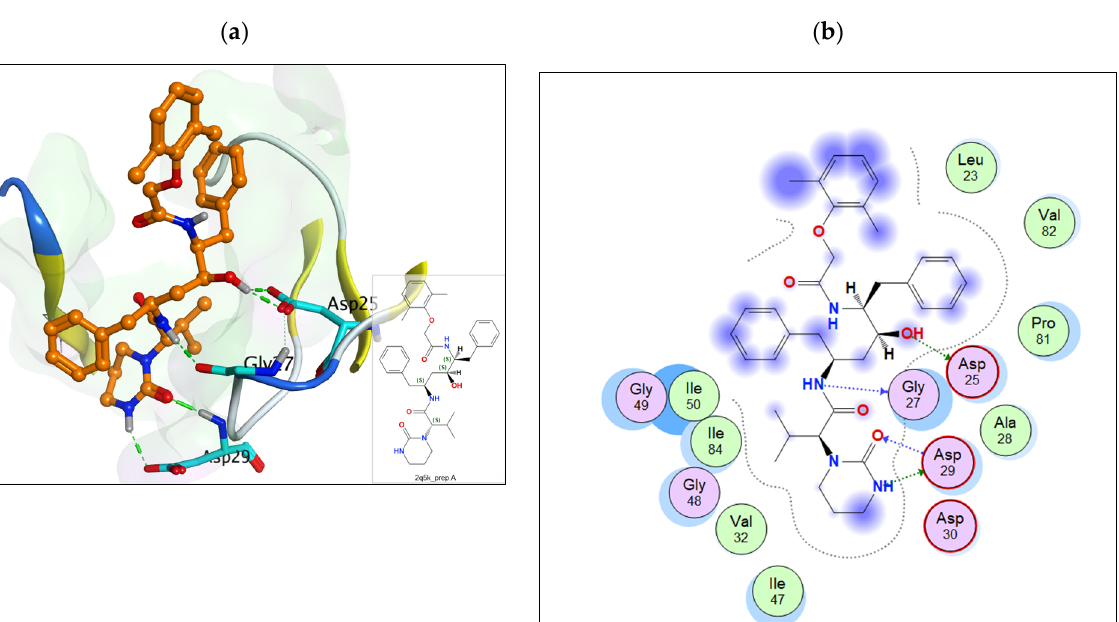
Figure 4. ( a ) The 3D and ( b ) 2D representation of lopinavir binding to the catalytic triad of 2Q5K. Table 3. Binding interactions of the hit compounds with 2Q5K.